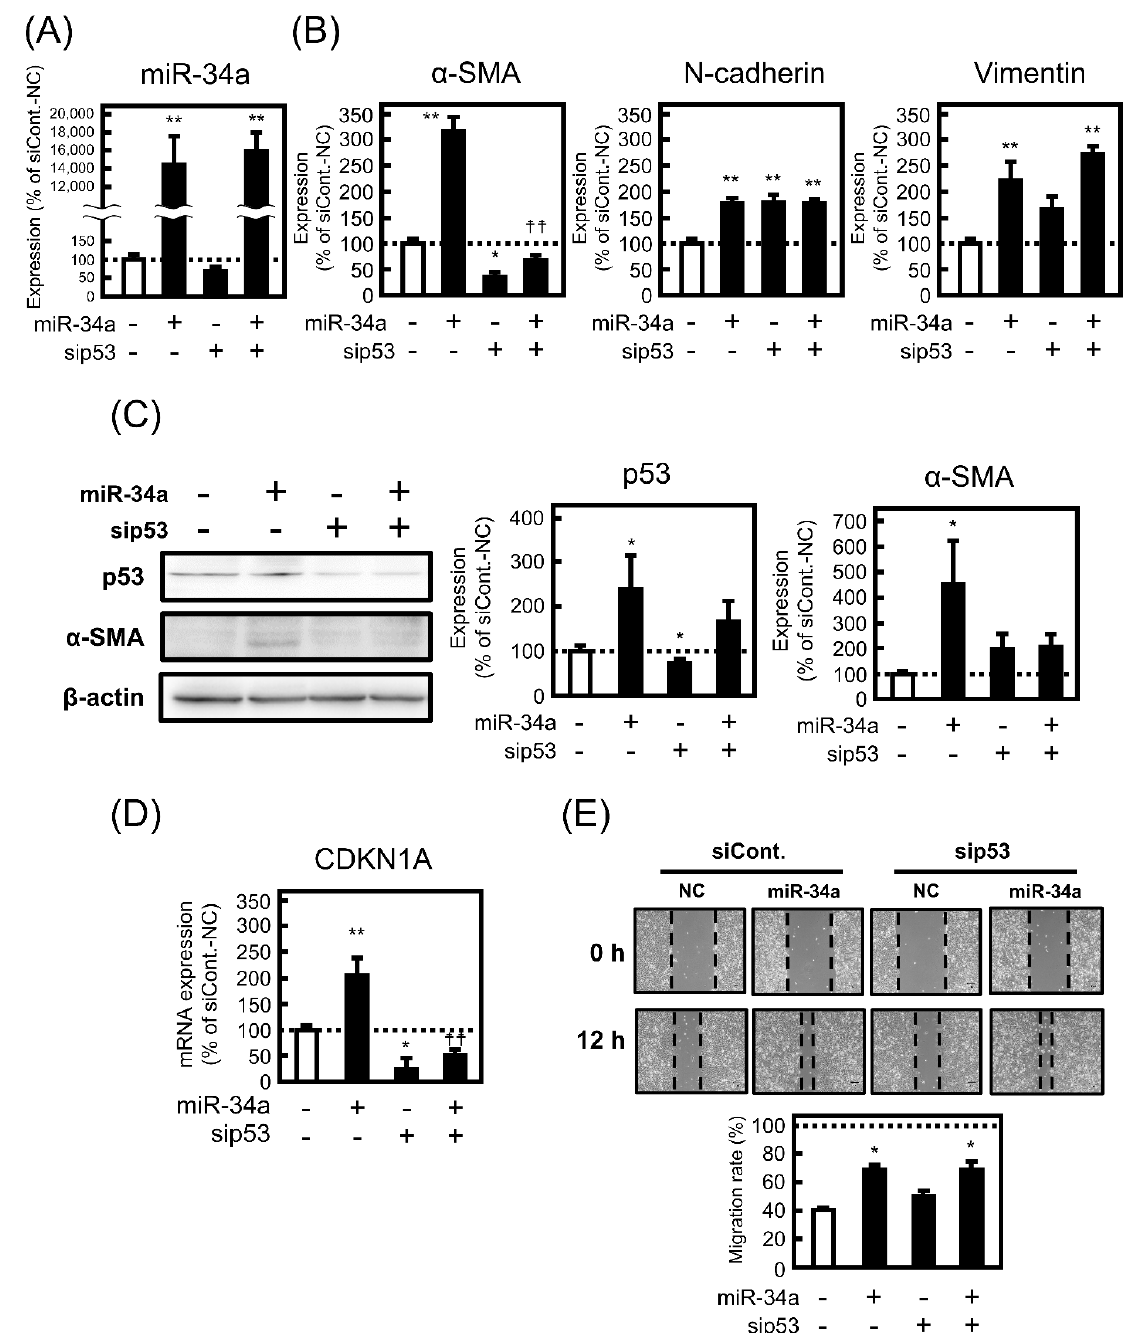
Figure 4. Contribution of p53 to EMT-related phenotypes in A549 cells under miR-34a overexpression. The cells were transfected with NC (20 pmol/well) or miR-34a mimic (20 pmol/well) under the control siRNA (siCont.; 10 pmol/well) or sip53 (10 pmol/well) for 24 h. After 72 h, ( A ) miR-34a and mRNA expression levels of ( B ) α -SMA, vimentin, N-cadherin, and ( D ) CDKN1A were measured by real-time PCR. ( C ) The protein levels of α -SMA and p53 were analyzed by Western blotting. ( E ) The migration ability was confirmed by scratch-wound assay as described in the Materials and methods section. Each value represents the mean ± S.E.M. (n = 3). * p < 0.05, ** p < 0.01, significantly different from NC under siCont. condition, †† p < 0.01, significantly different from miR-34a mimic under siCont.